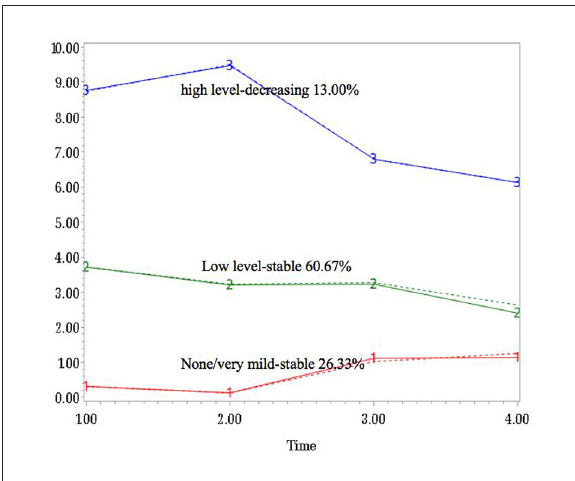
FIGURE1 Group-based trajectories for the anxiety changes over time.